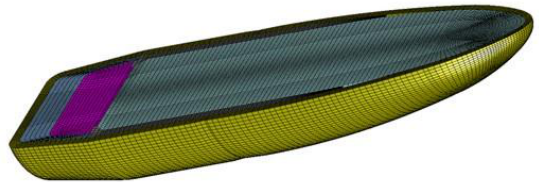
Figure 6. The mesh model with finite elements for the incendiary armor piercing bullet, 7.62 mm caliber.